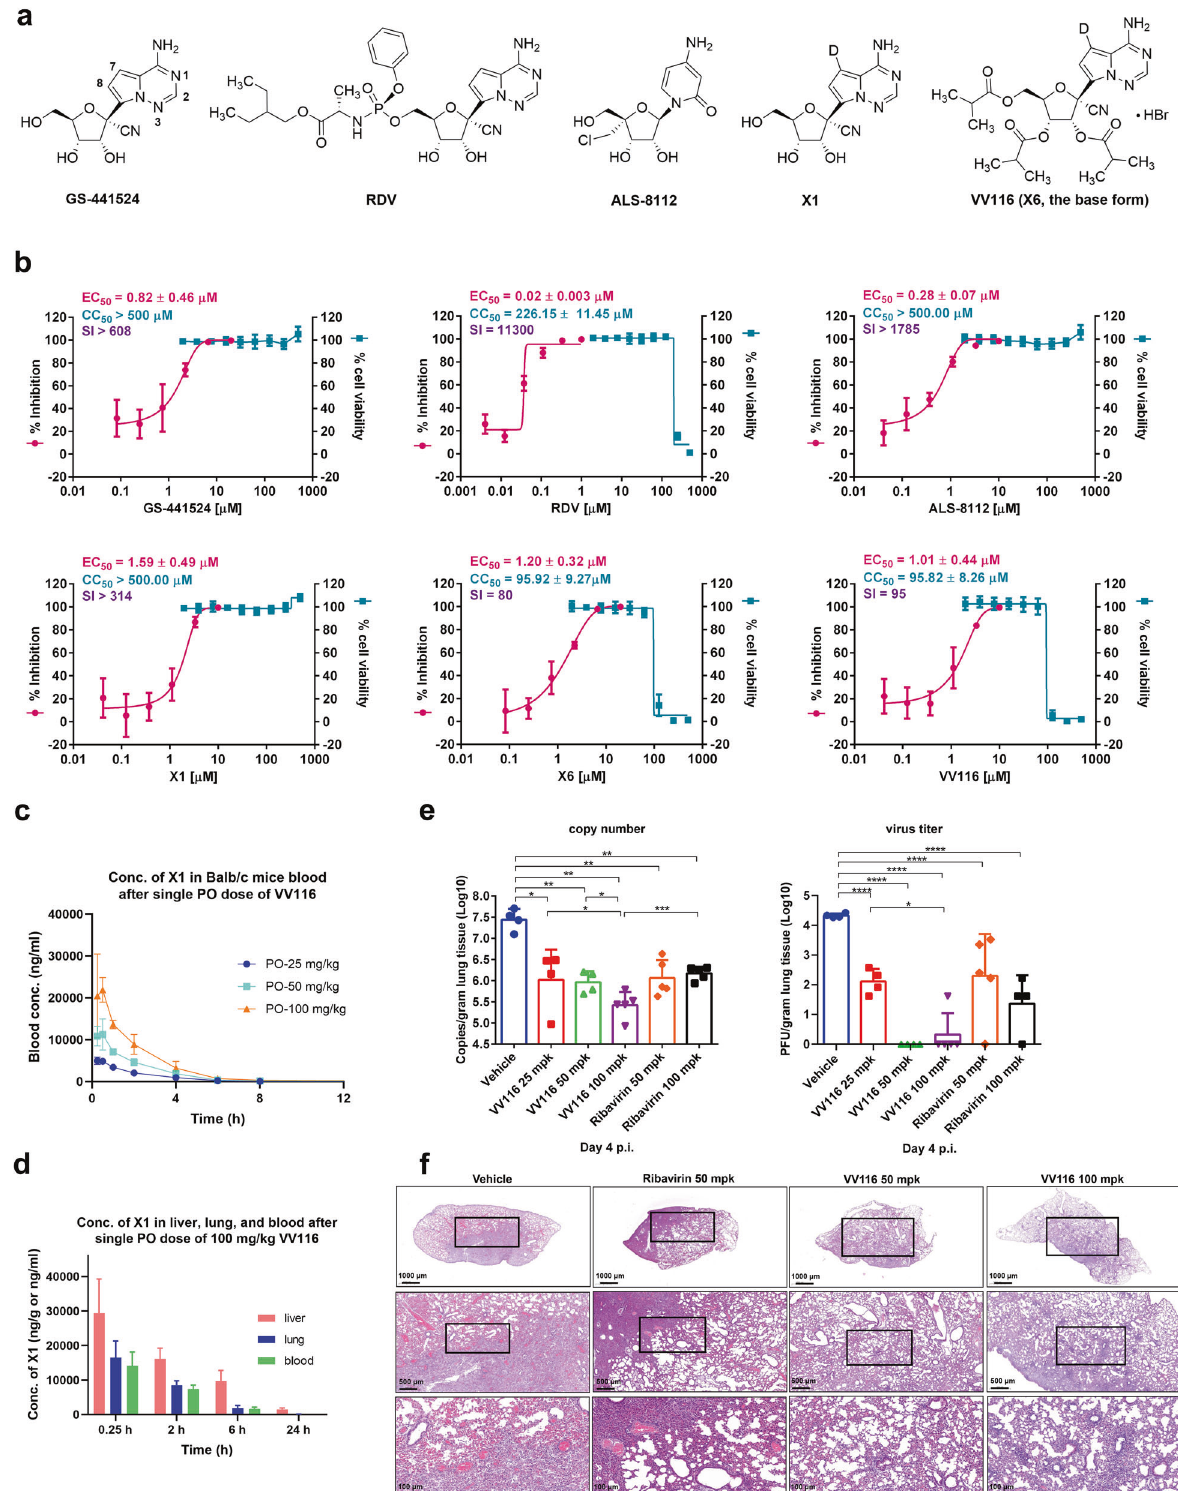
value of 85151 ng h/ml (Supplementary Table S9), ~3.5-folds of that at the dose of 50 mg/kg in mice. Nucleoside antiviral agents have a high genetic barrier to resistance since they target the highly conserved catalytic center of viral polymerase, and VV116 has been found to be effective against different SARS-CoV-2 variants. The favorable PK properties Signal Transduction and Targeted Therapy (2022)